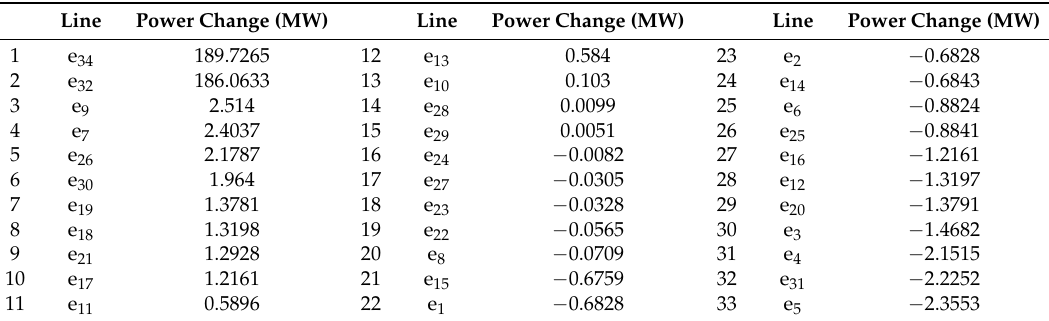
Table 1. Simulation result when line e 33 is